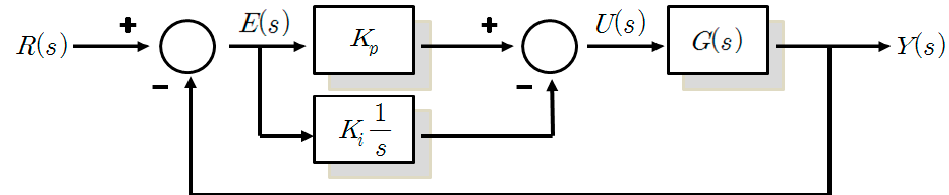
Figure 11. Real-time system block diagram.